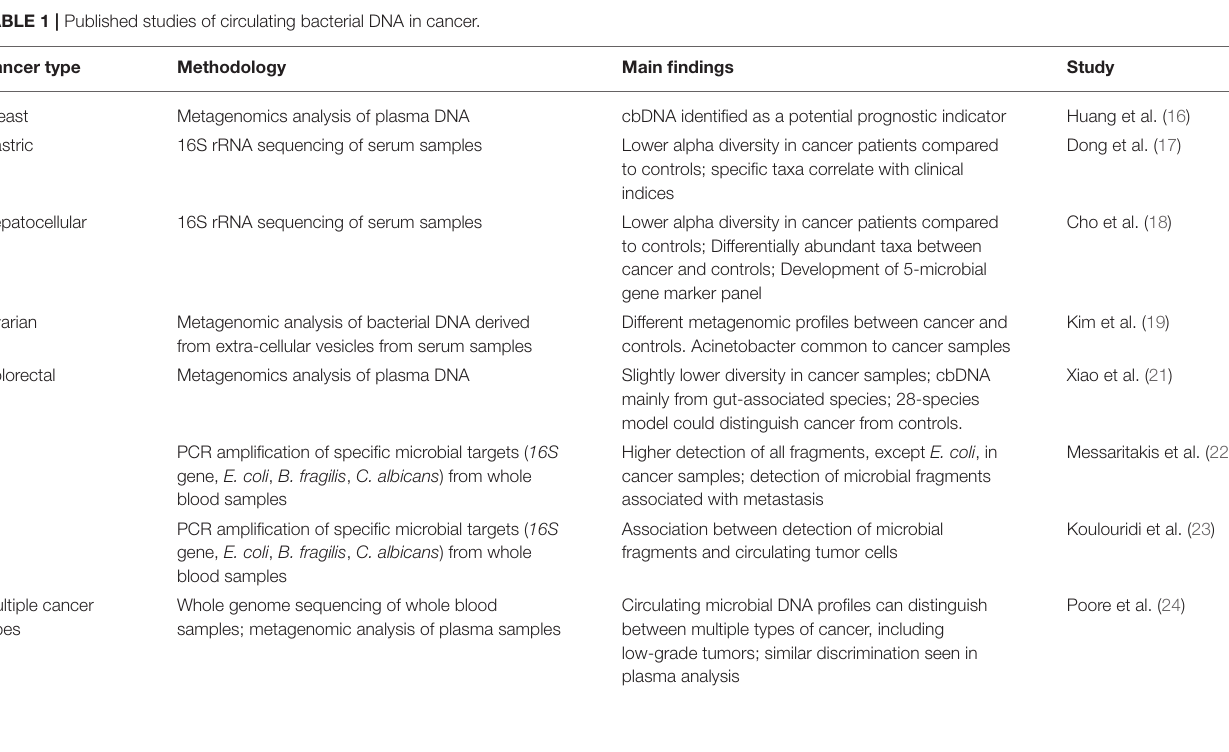
TABLE 1 | Published studies of circulating bacterial DNA in